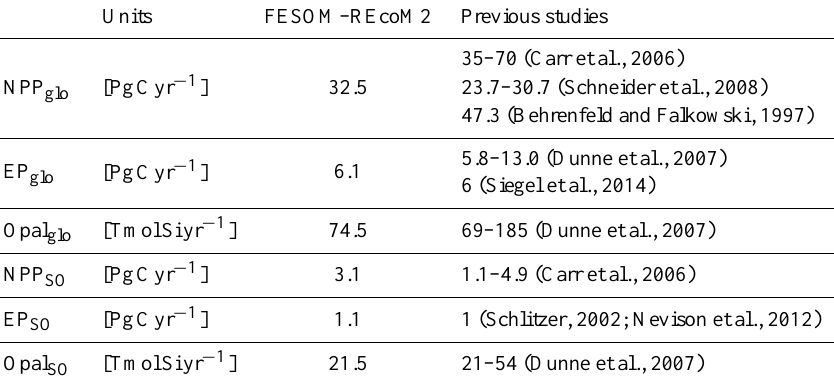
Table 3. Net primary and export production for the global domain and the Southern Ocean south of 50 ◦ S, for REcoM2 and from literature.